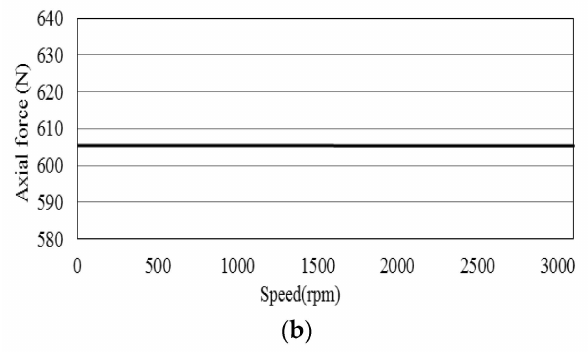
Figure 6. Axial force: ( a ) over 360 degrees; and ( b ) its average versus the rotor